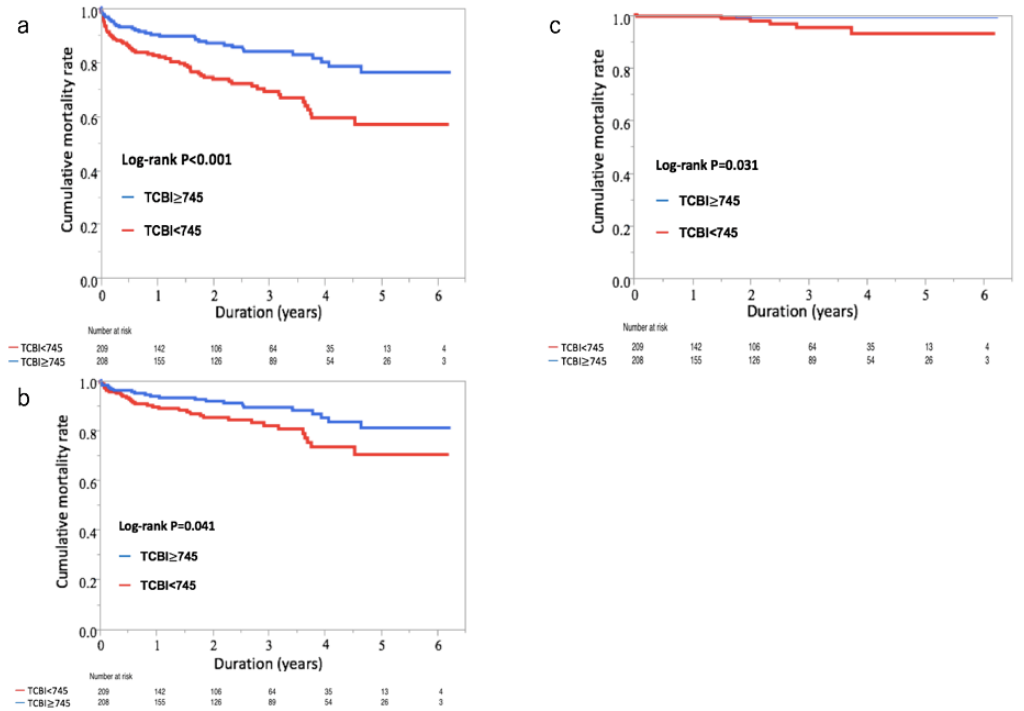
Figure 1. Cumulative event-free survival curves of all-cause, cardiovascular, and cancer deaths in patients with acute decompensated heart failure (ADHF). ( a ) Cumulative event-free survival curves of all-cause deaths in patients with ADHF. In the lower TCB index (TCBI) group, the cumulative incidence of all-cause deaths significantly increased compared with the higher TCBI (log-rank test: p < 0.001). ( b ) Cumulative event-free survival curves of cardiovascular deaths in patients with ADHF. In the lower TCBI group, the cumulative incidence of cardiovascular deaths significantly increased compared with the higher TCBI (log-rank test: p < 0.041). ( c ) Cumulative event-free survival curves of cancer deaths in patients with ADHF. In the lower TCBI group, the cumulative incidence of cancer deaths significantly increased compared with the higher TCBI (log-rank test: p < 0.031).